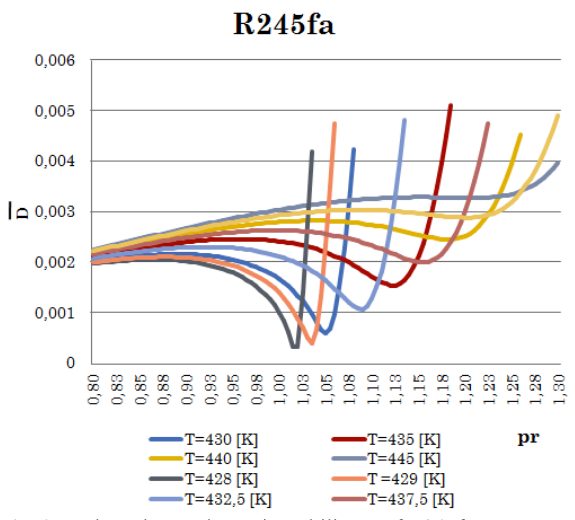
Fig. 3. Reduce thermodynamic stability D of R245fa